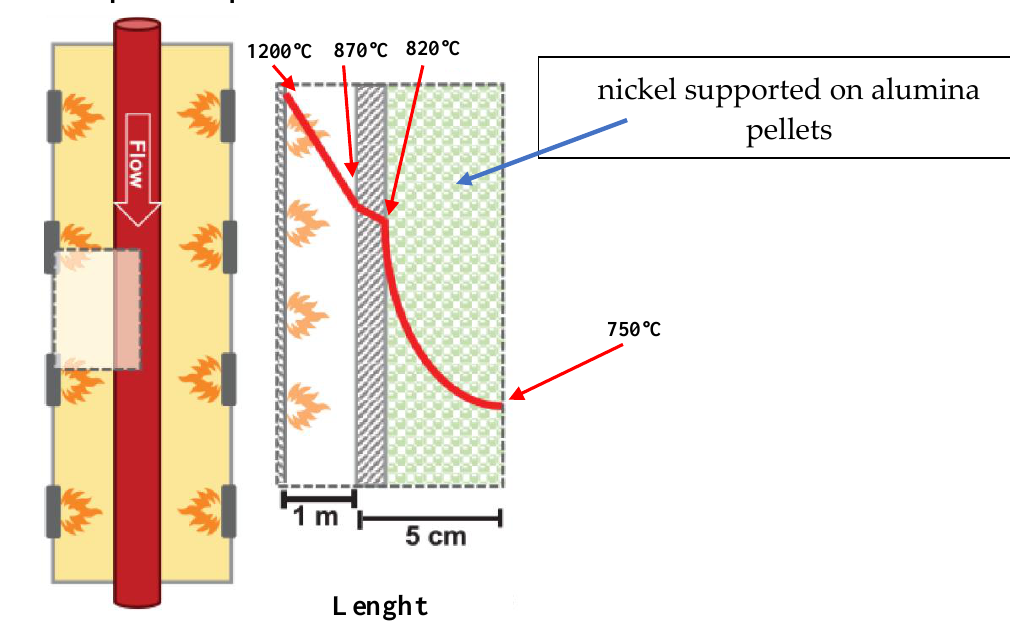
Figure 4. Temperature profile in a conventional steam reformer.